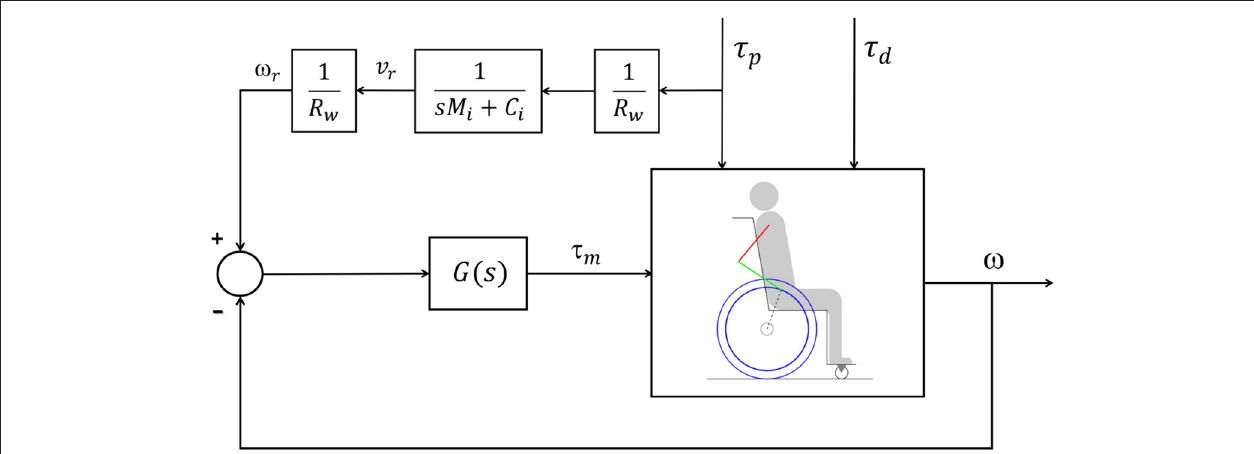
FIGURE 2 | Block diagram representing the impedance control loop, where the signal τ p is the user torque, τ d is the disturbance torque, τ m is the motor torque, v r is the reference rear wheel velocity generated by the reference model, ω r is the reference rear wheel angular velocity, and ω is the angular velocity of the wheelchair rear wheels. The transfer function G ( s ) represents the velocity controller. The parameter R w is the wheel radius, M i is the desired apparent mass and C i is the desired apparent friction